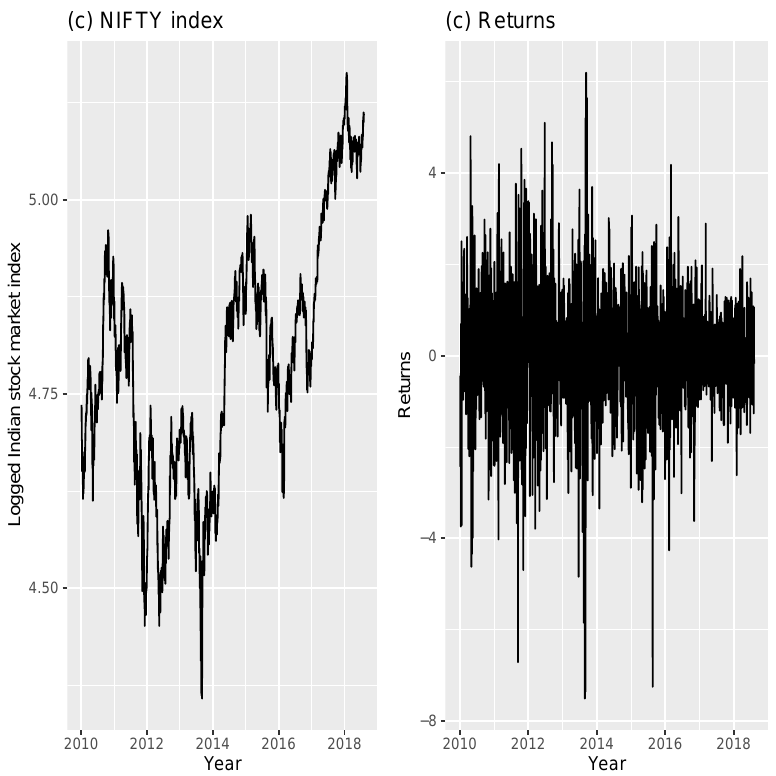
Figure 3. ( Left ) Plot of the Indian stock market index; ( Right ) Plot of the